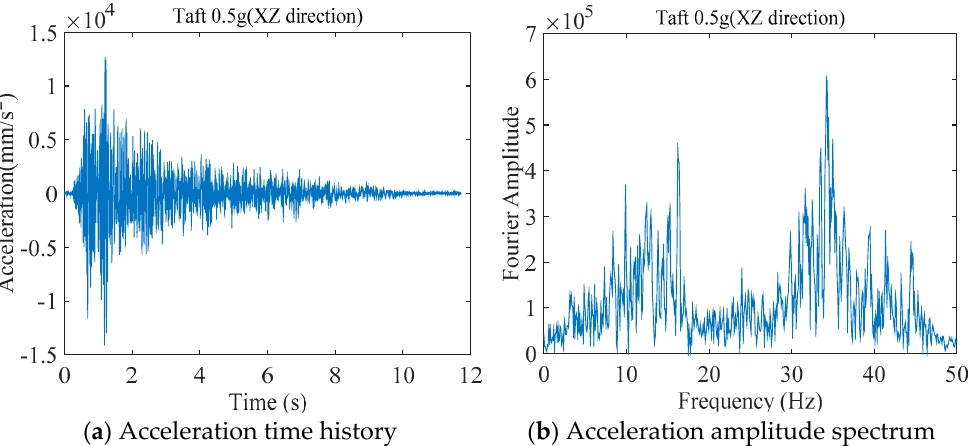
Figure 7. The measured acceleration record of the shaking table.